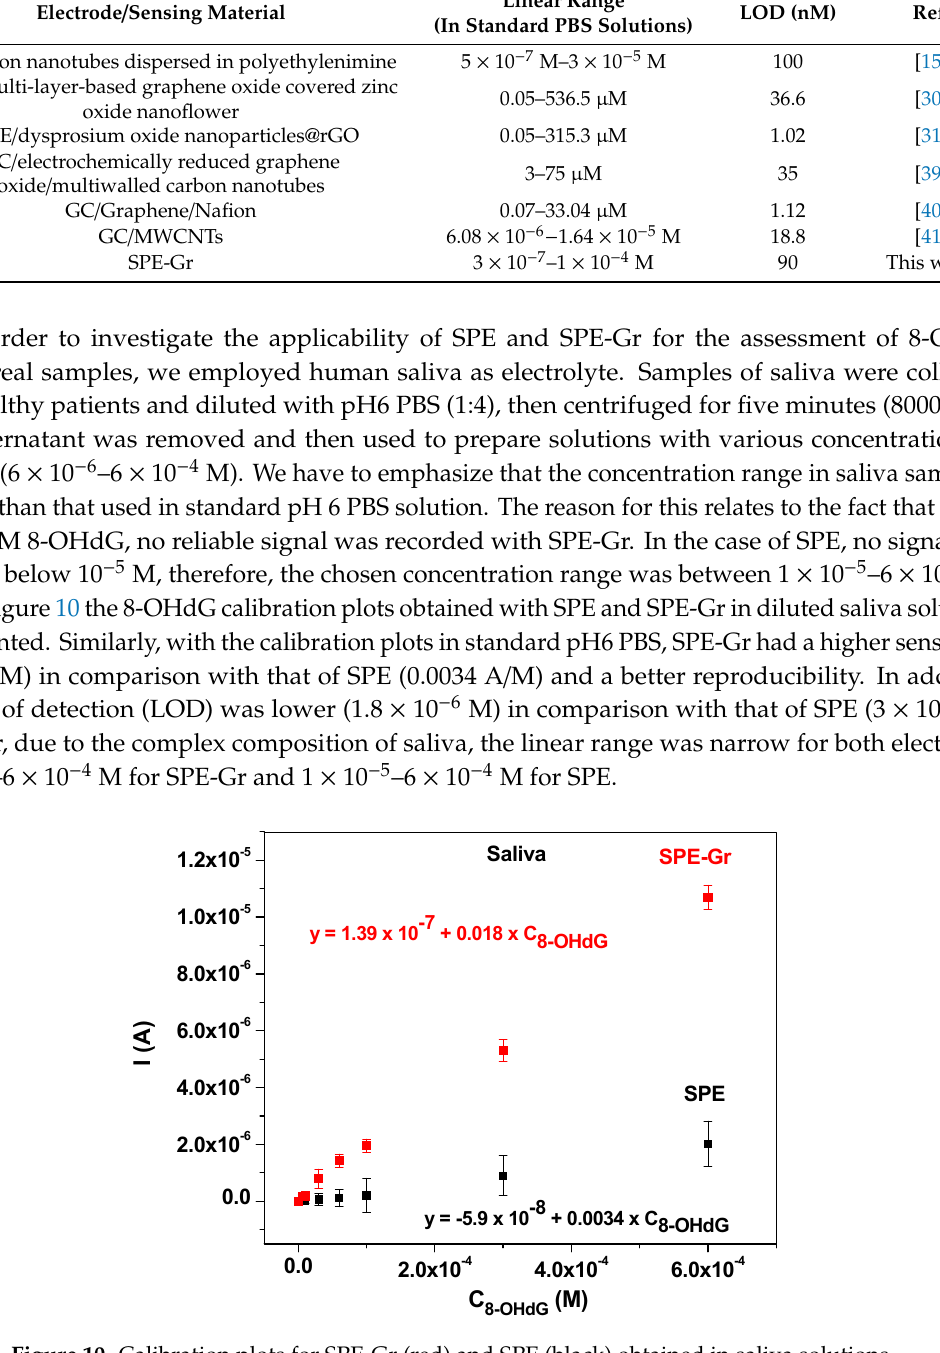
Table 3. Determination of 8-OHdG with SPE-Gr in spiked saliva samples.